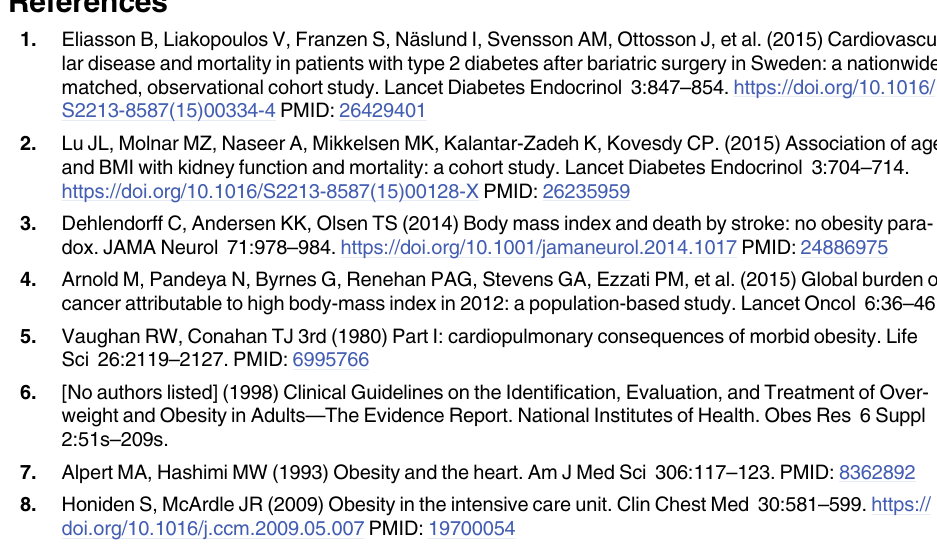
The risk of extubation failure in overweight and obese patients was associated with MIP level, cardiovascular system failure-related intubation, and underlying ESRD.